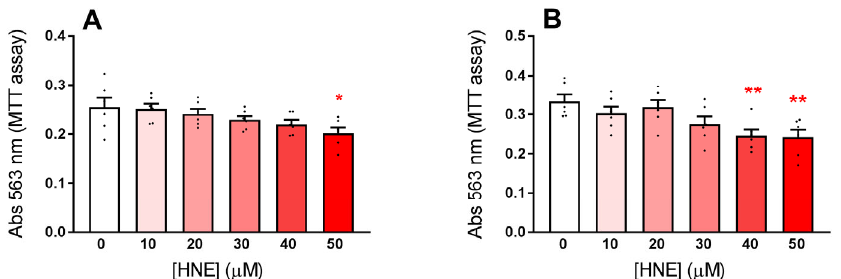
Figure 6. Effect of HNE on HLE cell viability. HLE cells were grown as described in Section 2.2 and maintained in MEM in the presence of the indicated HNE concentrations for 6 h ( A ) and 24 h ( B ). Cell viability was evaluated as described in Section 2.3. All values are reported as the mean ± SEM of six independent measurements. Statistical analysis was performed using one-way ANOVA with Tukey post hoc test. Significance was evaluated with respect to untreated cells (*: p < 0.05; **: p < 0.01).